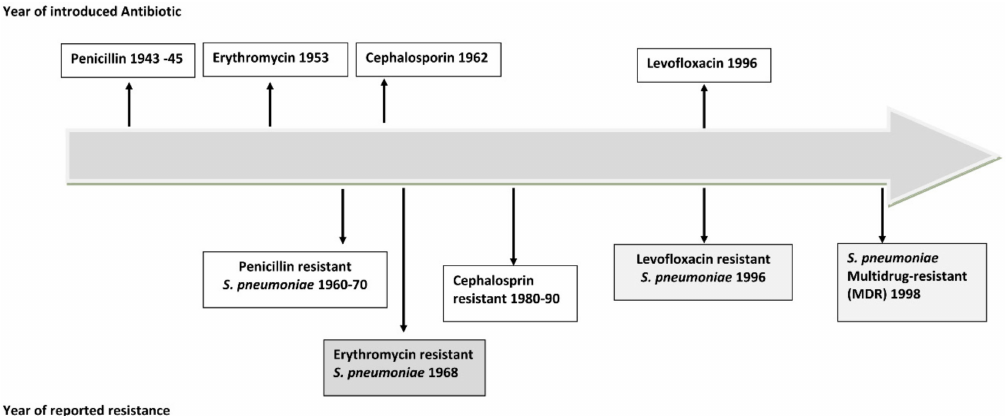
Figure 1. Timeline of antibiotic resistance of Streptococcus pneumoniae